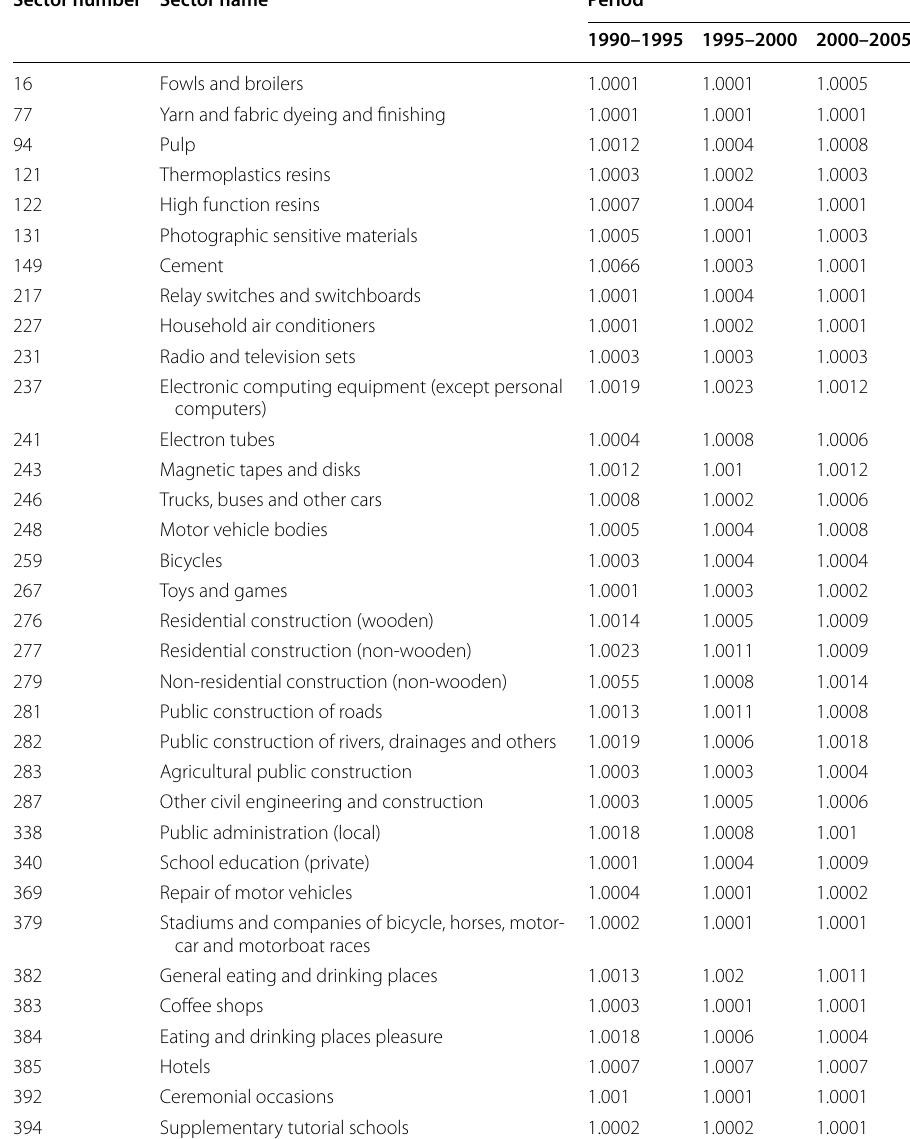
Table 2 Sectors whose backward linkage increased GHG emissions in Japan in all the study periods (1990–1995, 1995–2000 and